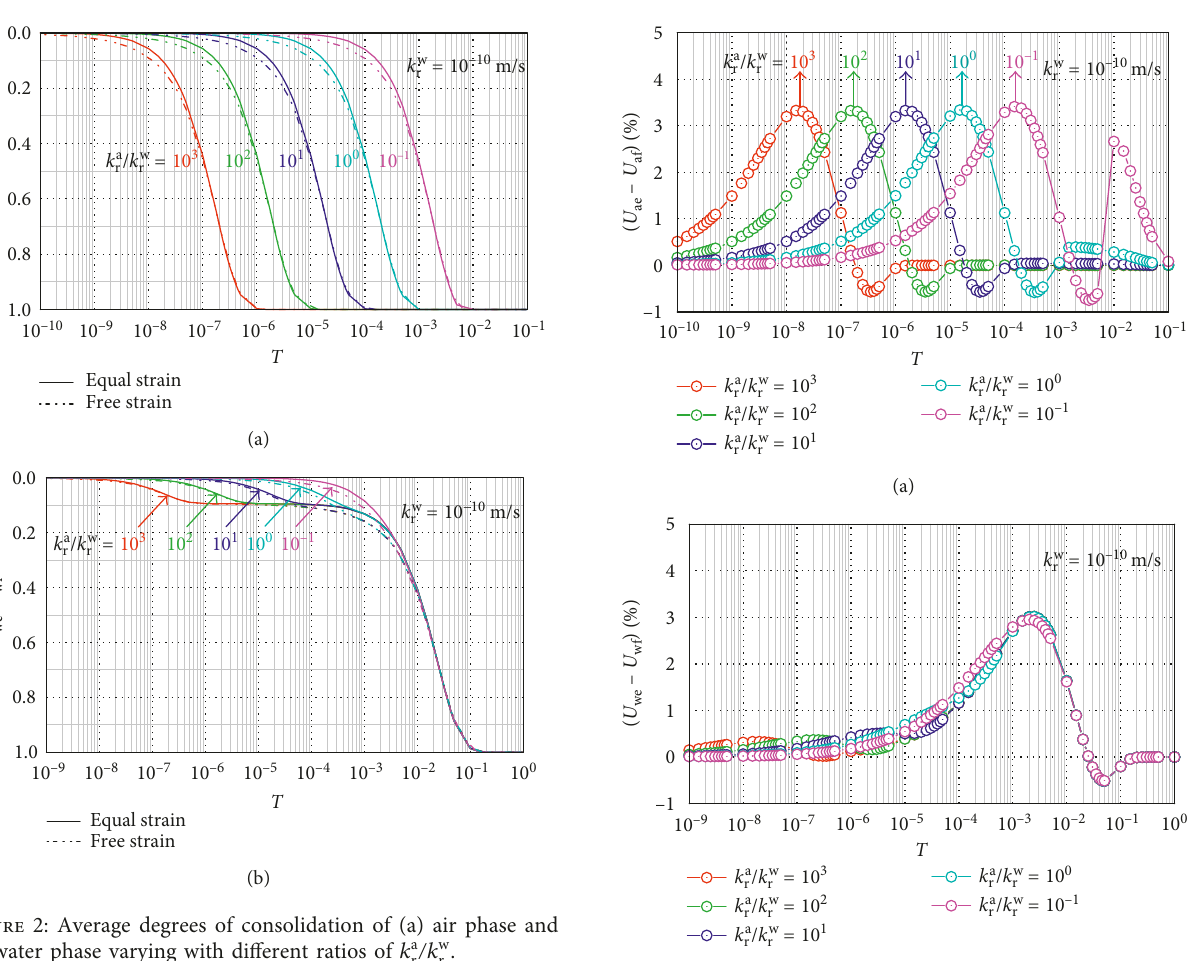
/k w . r r Figure 3: Difference of degrees of consolidation in (a) air phase and (b) water phase varying with different ratios of k a